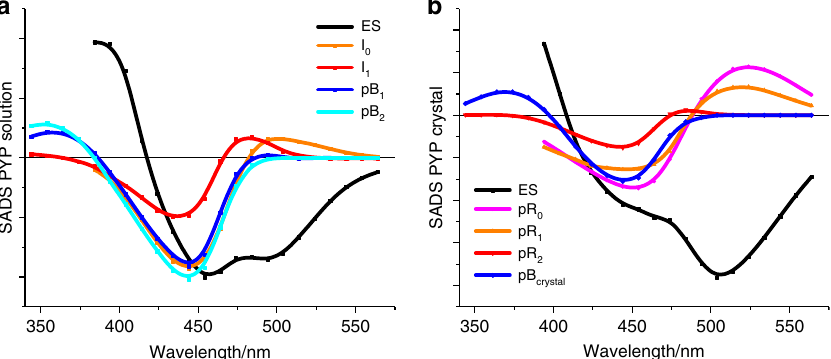
Fig. 5 UV – Vis SADS of PYP. The SADS in solution ( a ) and crystalline ( b ) form have been resolved from fi tting the target model shown in Fig. 4 to the experimental data, and display the bleached ground state, and stimulated emission, as negative features and induced absorption as positive features. The characteristic blue ( ≈ 370 nm) absorption of pCA in the pB states signals protonation of pCa. The region of the ground state bleach in the PYP C dataset appears to be diminished with respect to that in PYP S ; this is an effect of the high absorption of the crystals around 444 nm. Note that data from Yeremenko et al. 19 has been added to the analysis to more reliably estimate the dynamics and SADS on the ~10 – 300 ms timescale and to span the full photocycle dynamics up to 1 s. Source data are provided as a Source Data fi